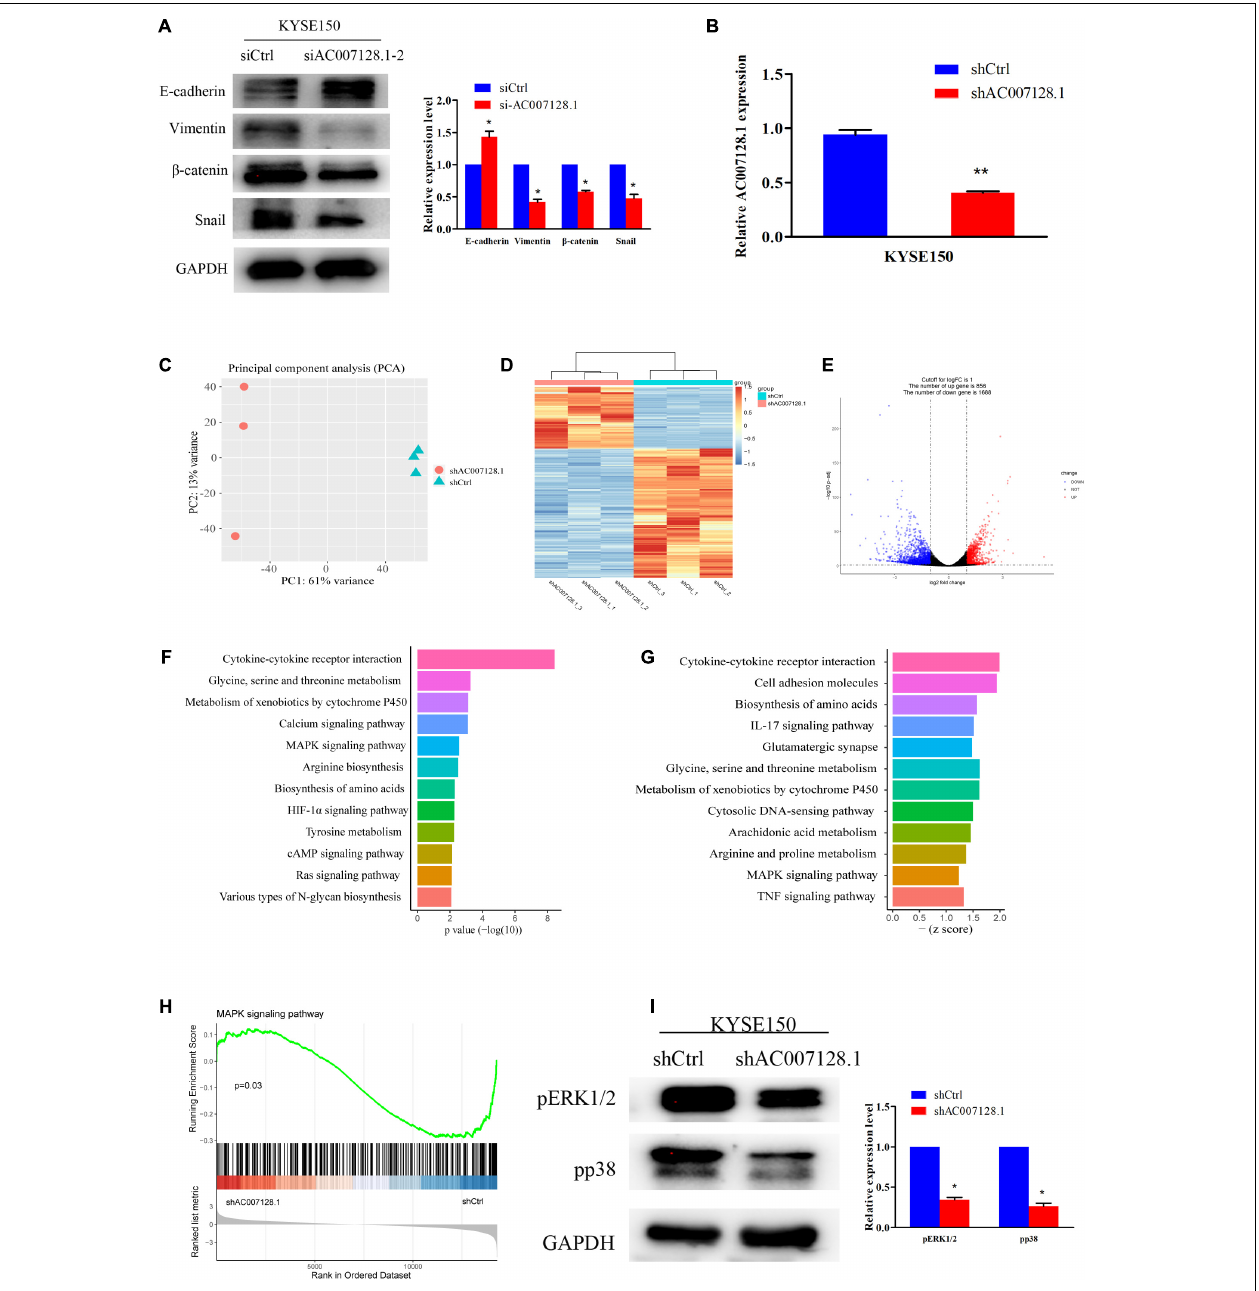
FIGURE 6 | AC007128.1 activates MAPK/ERK and MAPK/p38 signaling pathways. (A) AC007128.1 depletion resulted in the increased expression of epithelial marker and decreased expressions of mesenchymal markers. (B) qPCR analysis of AC007128.1 expression in shAC007128.1- and shCtrl-treated ESCC cells. (C) PCA showed successful segregation between shAC007128.1 and shNC groups. (D) Heatmap analysis showed that shAC007128.1 cells could be distinguished by dysregulated lncRNAs. (E) Volcano plot exhibited differentially expressed lncRNAs. (F) KEGG analysis indicated the down-regulated signaling pathway by repressed genes in AC007128.1-depleted cells. (G) GSEA showed the repressed signaling pathway in AC007128.1-depleted cells. (H) GSEA indicated that AC007128.1 depletion might inhibit the MAPK signaling pathway. (I) Depletion of AC007128.1 obviously decreased the expressions of p-ERK1/2 and p-p38. * P < 0.05 and ** P < 0.01 by Student’s t-test as compared with the corresponding